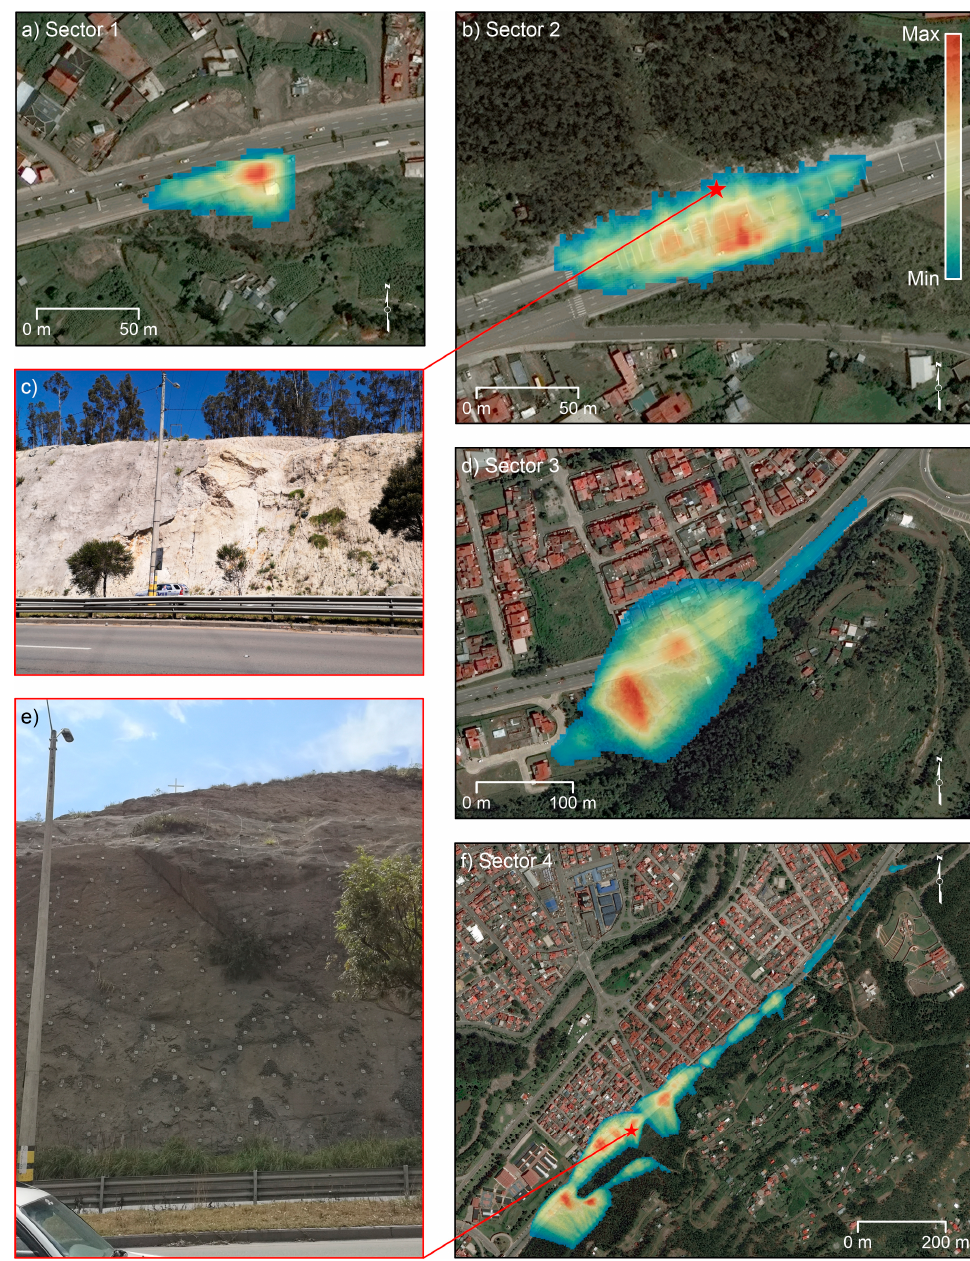
Figure 8. Outcomes of QPROTO algorithm for sector n° 1 ( a ), 2 ( b ), 3 ( d ), 4 ( f ) with different classes of potential rockfall runout occurrences; pictures ( c , e ) show the slopes prone to collapse for sector 2 and sector 4, respectively.